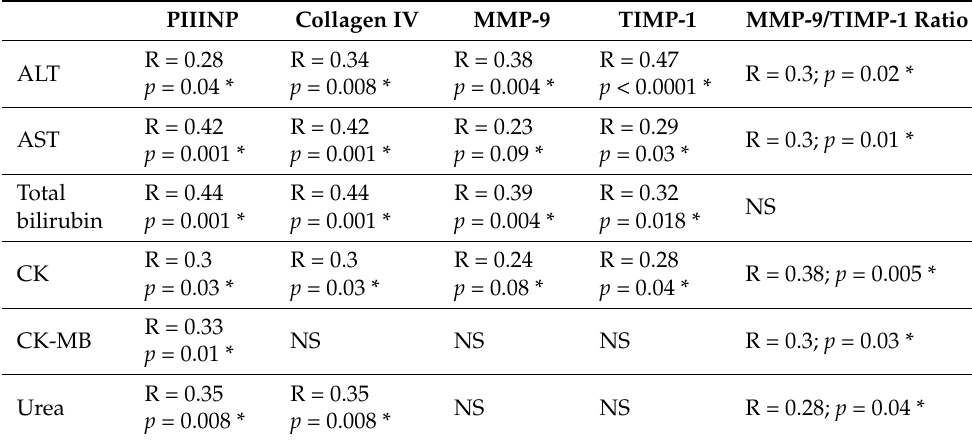
Table 4. Correlations of fibrosis markers with laboratory results in study